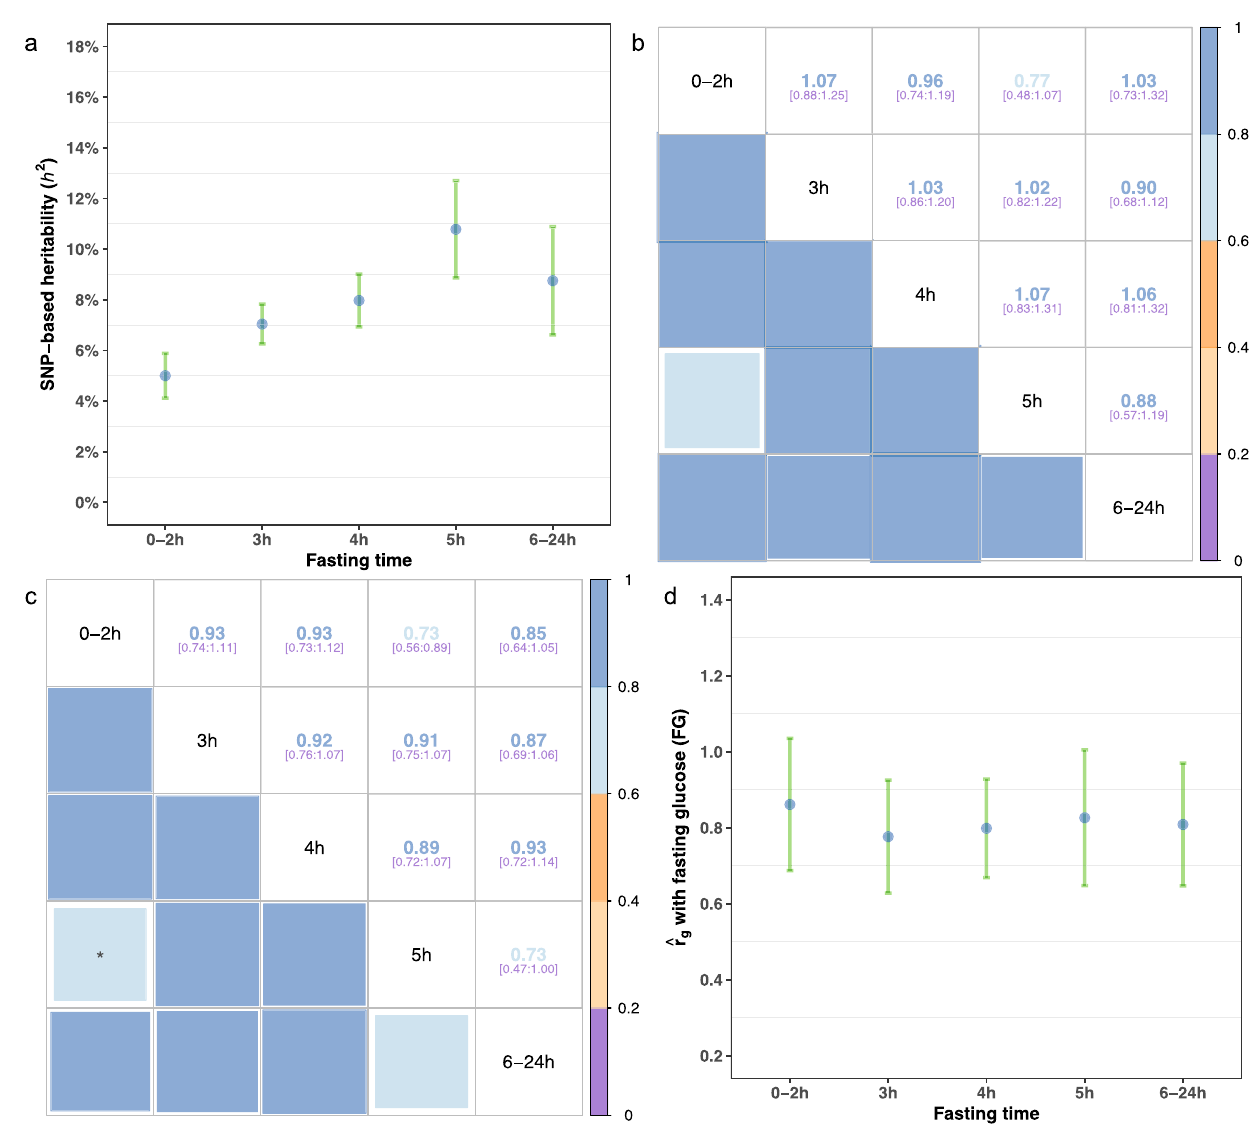
Fig. 1 | Estimation of time-dependent genetic architecture parameters for random glucose in UKB. a SNP-based Heritability ( h 2 ) estimates for each sub- group,obtainedthroughHaseman-Elstonregressionanalysisbasedonallsamples, are presented with 95% con fi dence intervals (95% CIs). b Genetic correlation esti- mates (and their 95% CIs) between pairwise subgroups obtained through LDSC analysis. c Genetic correlation estimates (and their 95% CIs) between pairwise subgroups obtained through Haseman-Elston regression analysis. The only pair of subgroups with a genetic correlation signi fi cantly lower than 1 after Bonferroni correction is marked with an asterisk. d Genetic correlations between fasting